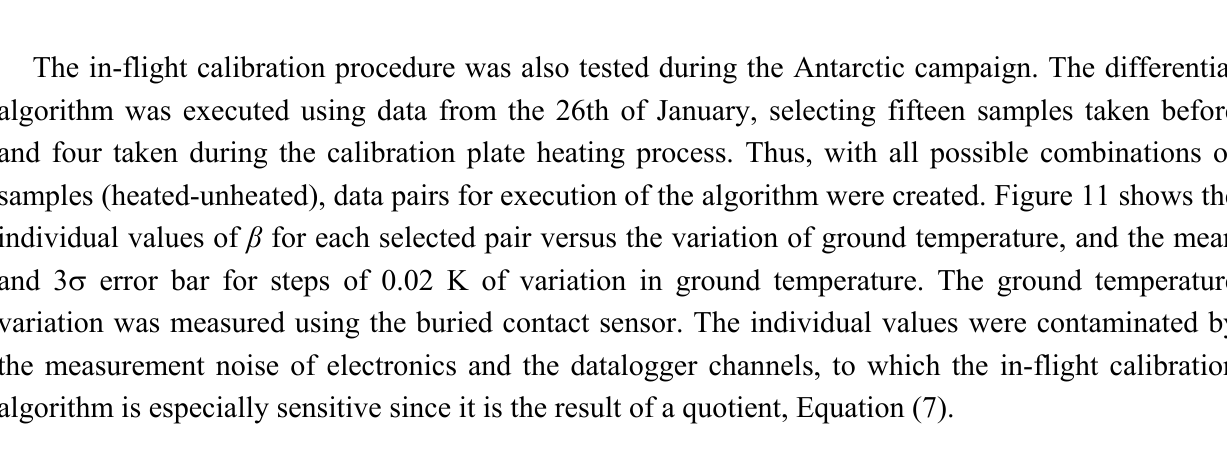
Figure 11. Specific and average values for estimation of  constant.